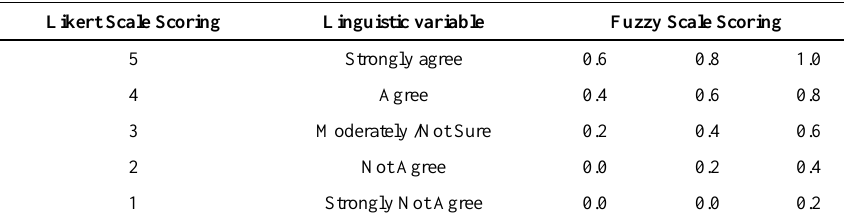
Table 2. Variable for the importance weight of